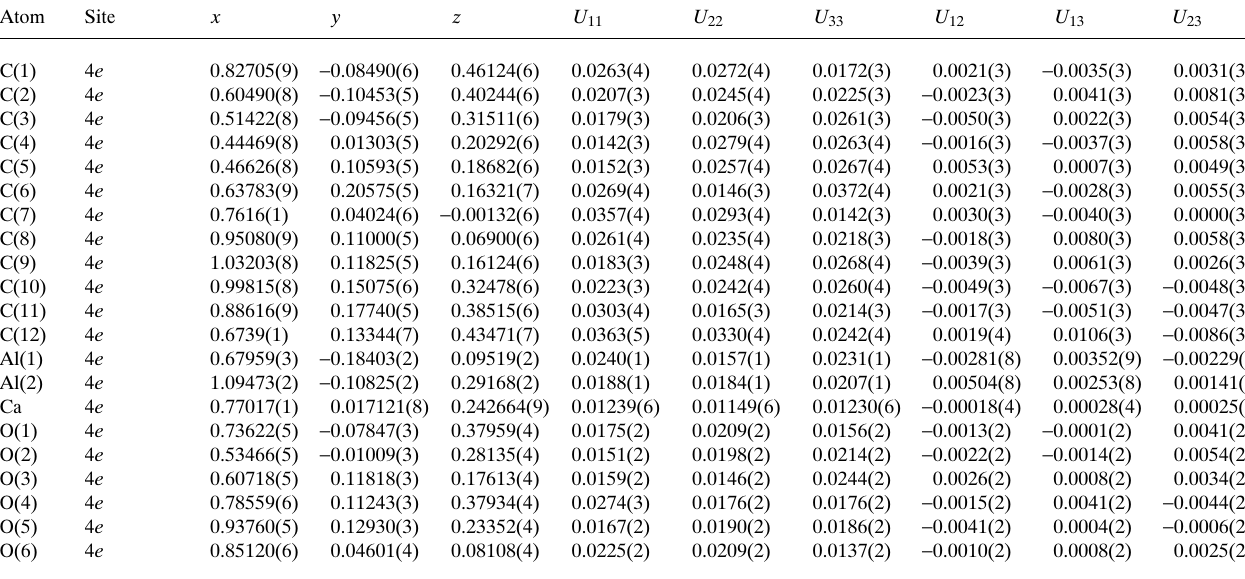
Table 3. Atomic coordinates and displacement parameters (in Å 2 )